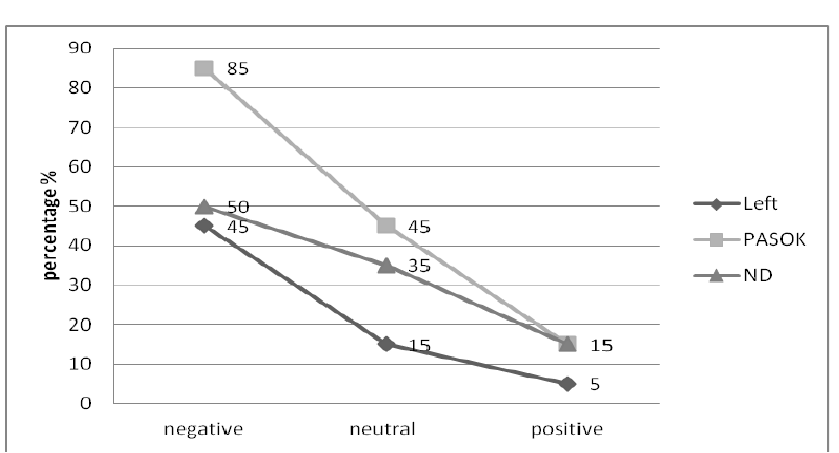
Figure 1. Percentages of the 20 central blogs with negative, neutral or positive references to the Greek political